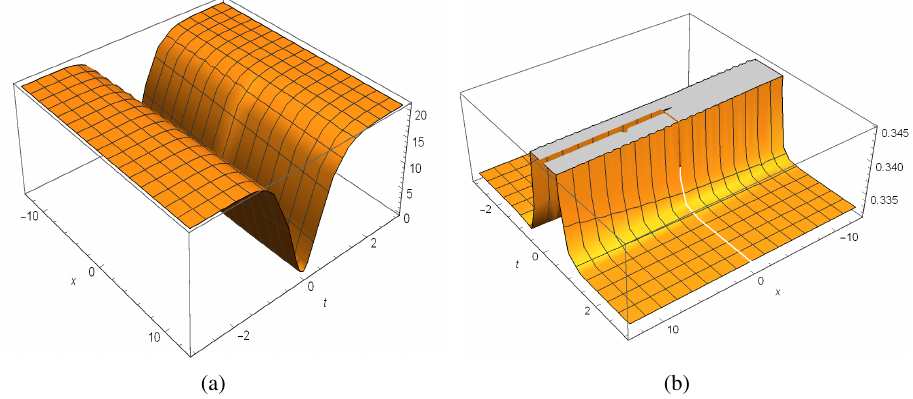
Fig. 1 The 3D surfaces of (a) Eq. (4.7) and (b) Eq. (4.8) with fractional value α = 0 . 9.